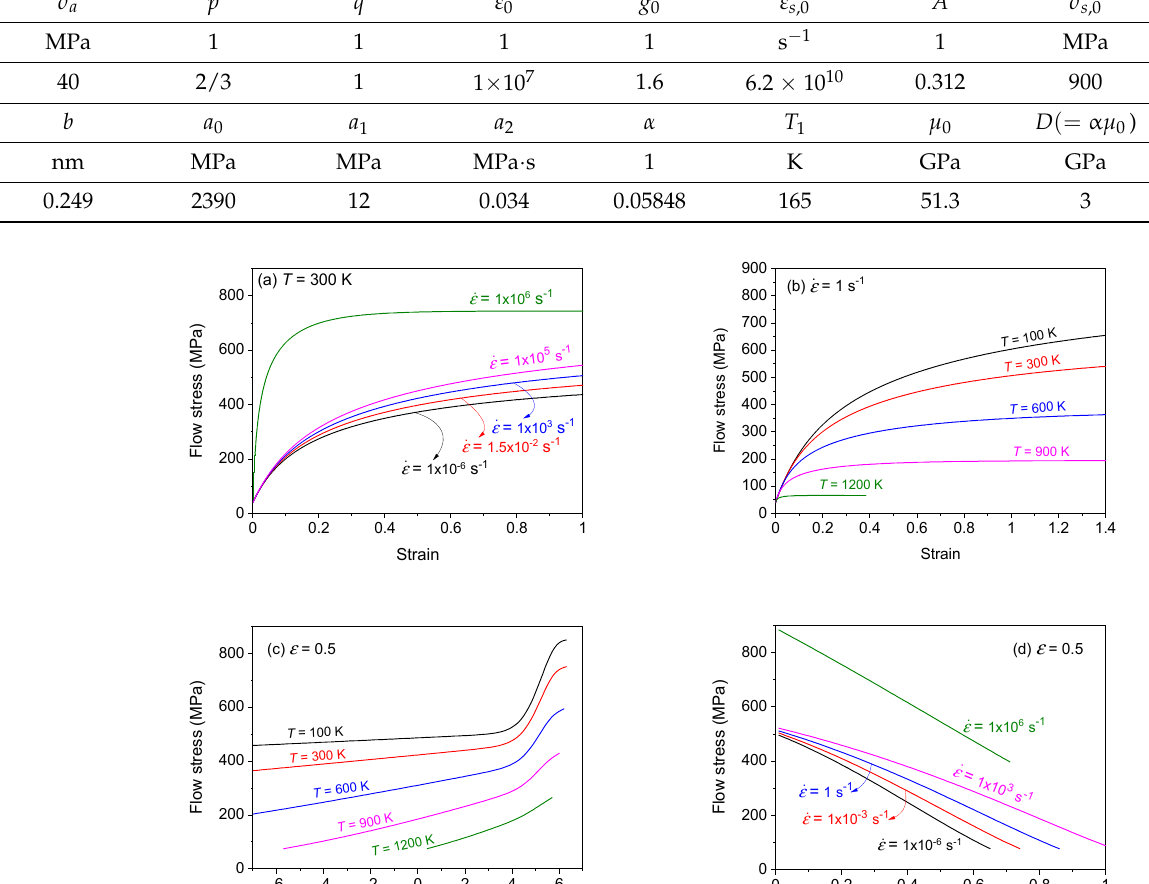
. ε ∗ = 1 s − 1 , T m = 1356 K). . . (cid:0) . (cid:1) ε / ε ∗ ε ∗ = 1 s − 1 is presented in Figure 25c (